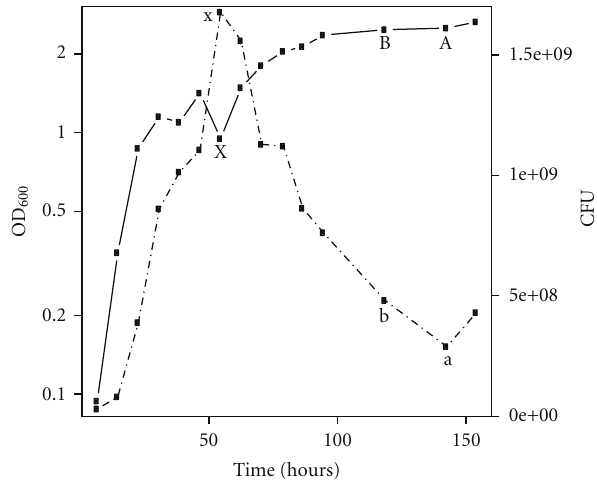
Figure 1: Growth of Halobacterium salinarum NRC-1. The Halobacterium salinarum NRC-1 growth curve derived from data originally presented in Facciotti et al. [12]. OD 600 , displayed against the left y -axis in logarithmic scale, is denoted by open circles. CFU, displayed against the right y -axis in linear scale, is denoted by closed circles. Points X and x (representing OD 600 and CFU, respectively) mark the initial reference point for GV supplementary experiments. Point pairs A and a, and B and b, denote the corresponding OD 600 and CFU data where the two largest CFU decreases were observed. Point pairs (A, a and B, b) along with reference points (X, x) were used to calculate the number of GVs released into media during stationary